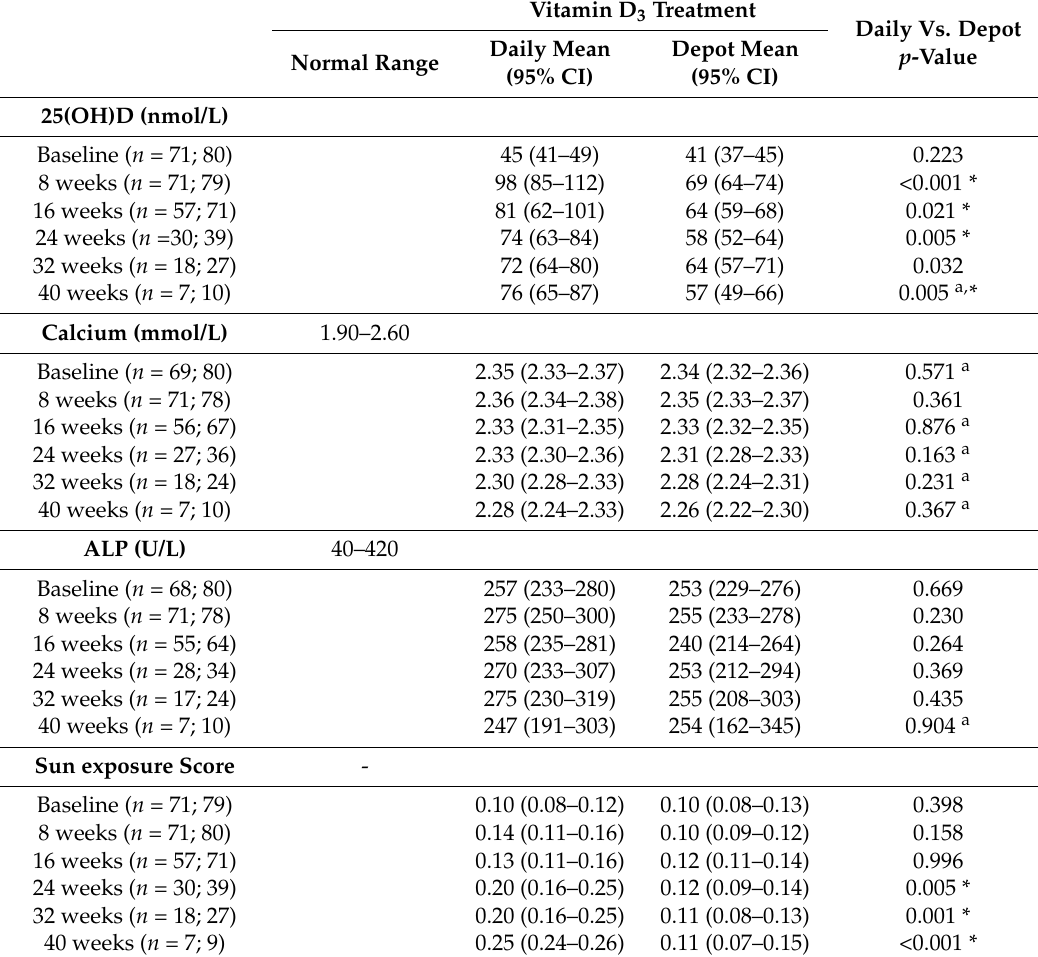
Table 2. Biochemical and sun exposure